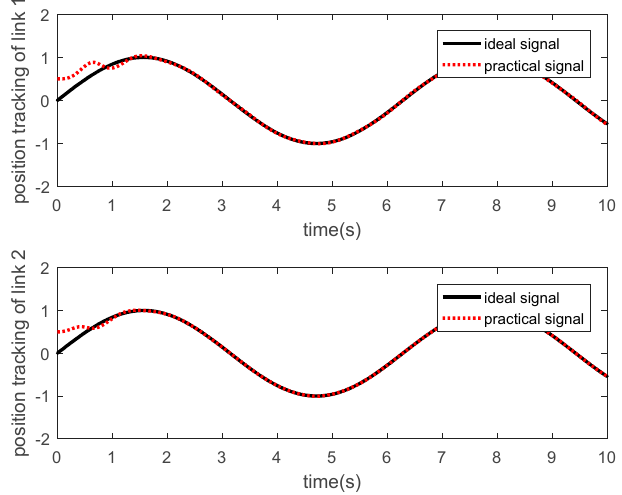
Figure 10. Angle tracking of joints 1 and 2.